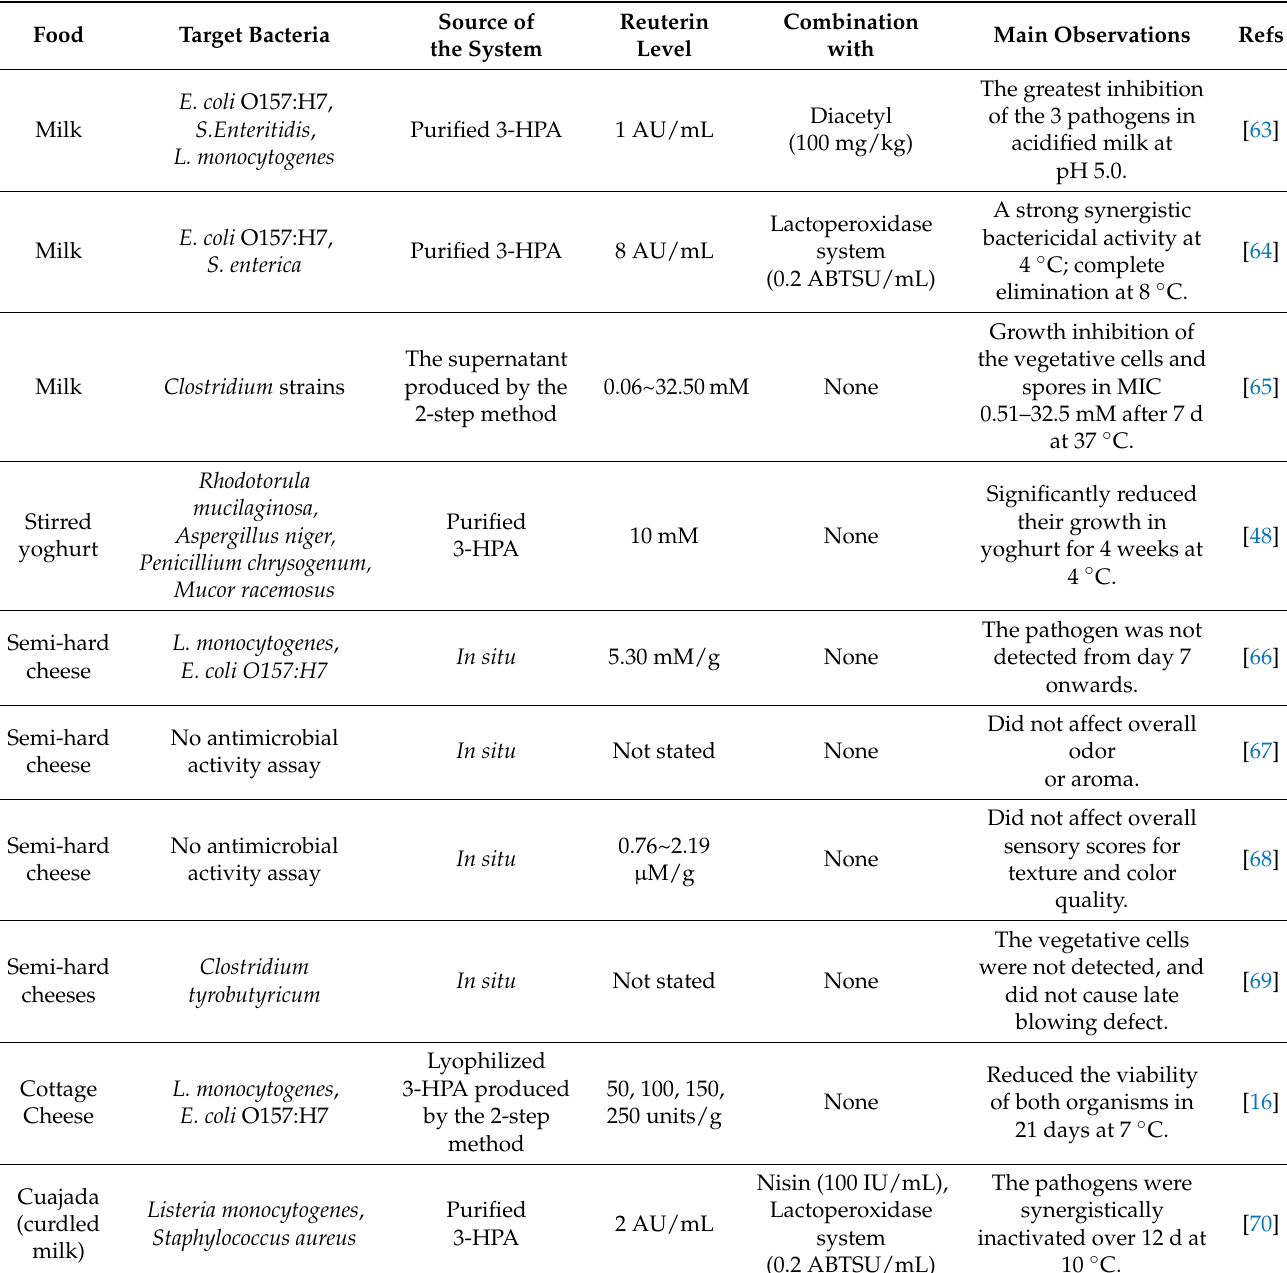
Table 2. The use of the reuterin system as preservative in dairy